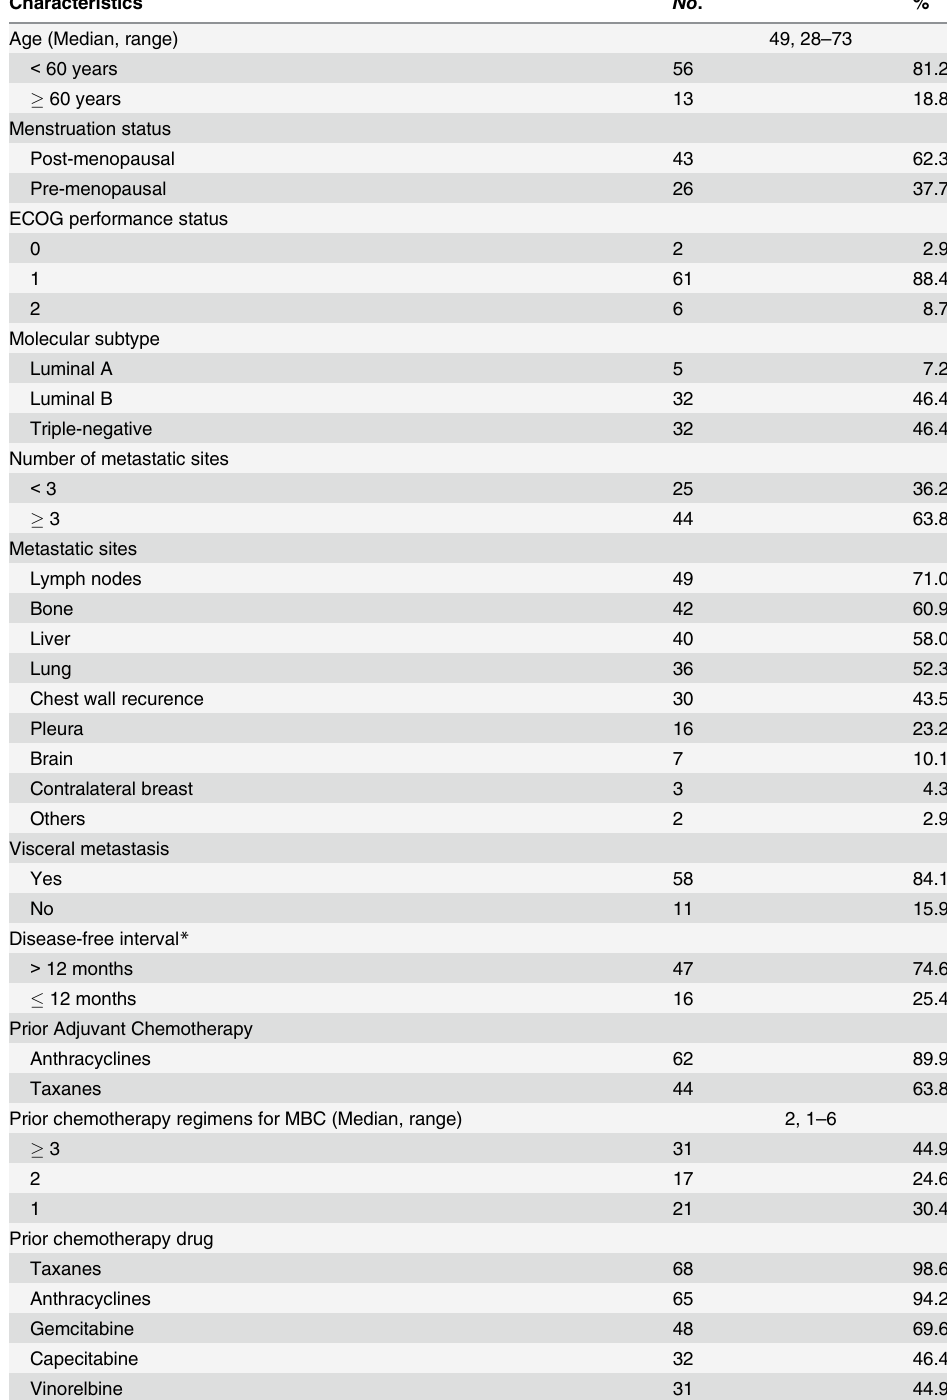
Table 1. Patient Characteristics at baseline ( N = 69). Abbreviations: ECOG, Eastern Cooperative Oncol- ogy Group; MBC, metastatic breast